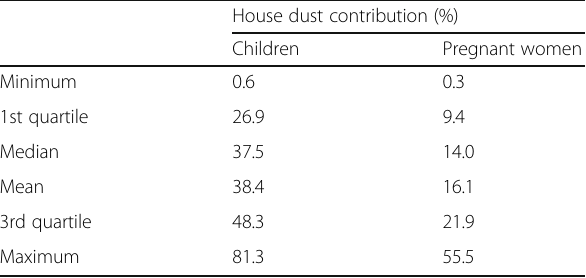
Table 2 Contribution of house dust in oral lead exposure (%) House dust contribution